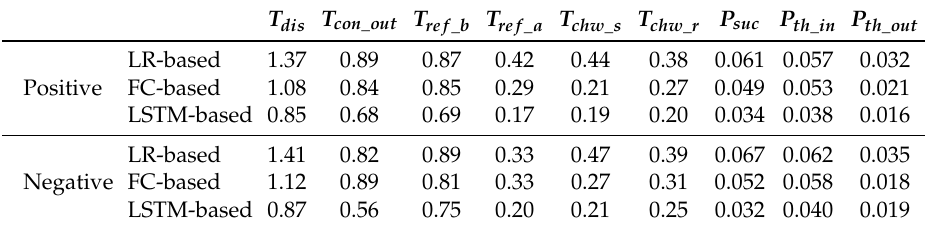
Table 7. MAE of the remaining sensors during